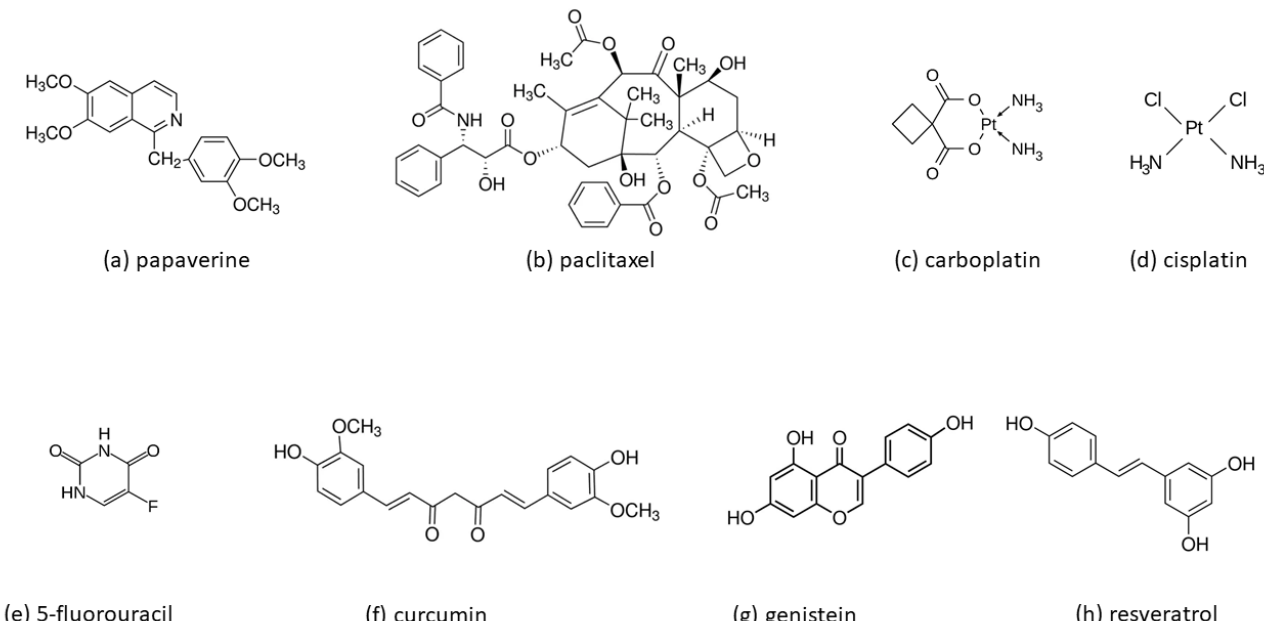
Figure 3. Molecular structures of small plant-derived molecules radiosensitizers discussed in this review: ( a ) papaverine, ( b ) paclitaxel, ( c ) carboplatin, ( d ) cisplatin, ( e ) 5-fluorouracil, ( f ) curcumin, ( g ) genistein and ( h ) resveratrol.